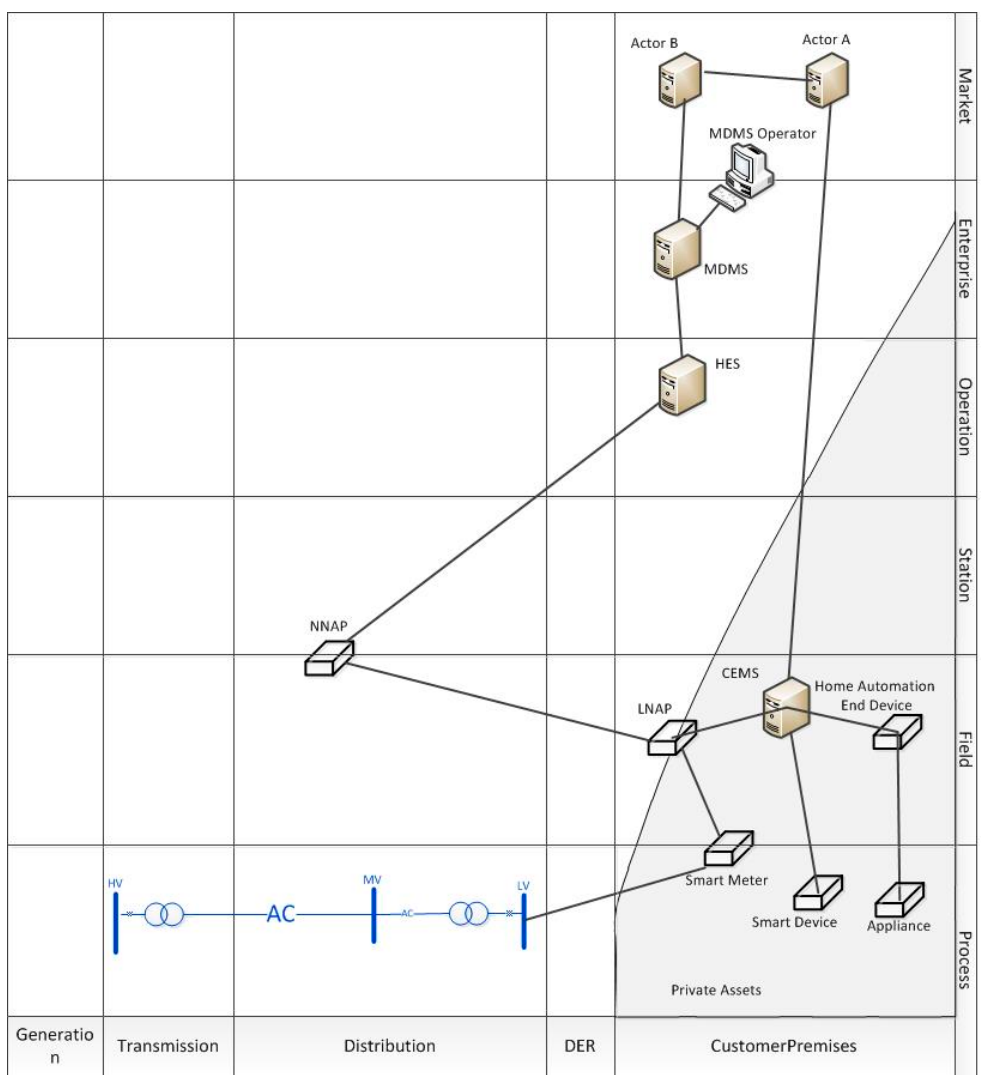
Figure 4. Component Layer.